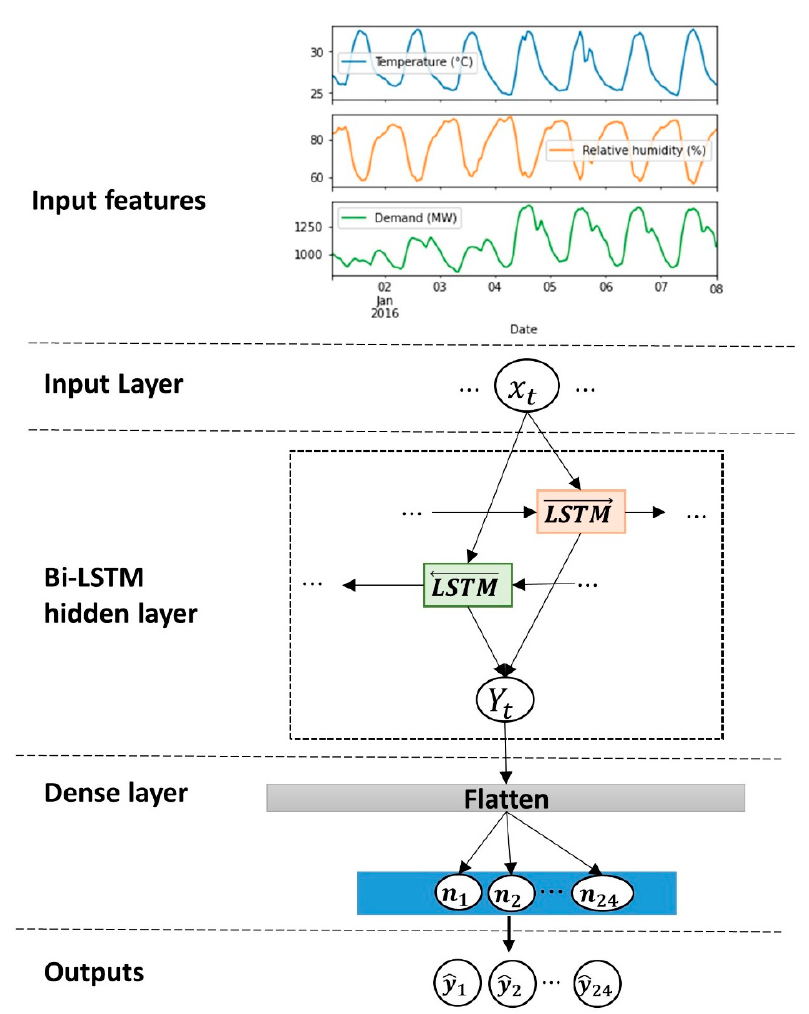
Figure 3. Bi-LSTM architecture for multi-step prediction of electricity demand.